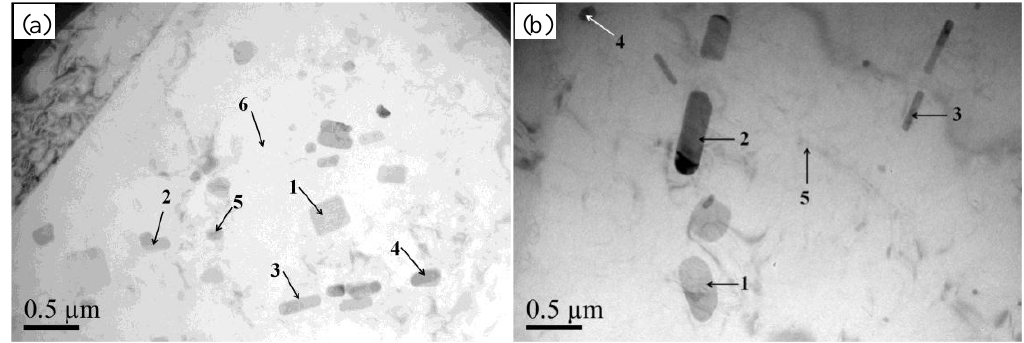
Figure 5. TEM images of ( a ) annealed and ( b ) quenched 5083 aluminum alloy sheets before tensile deformation.